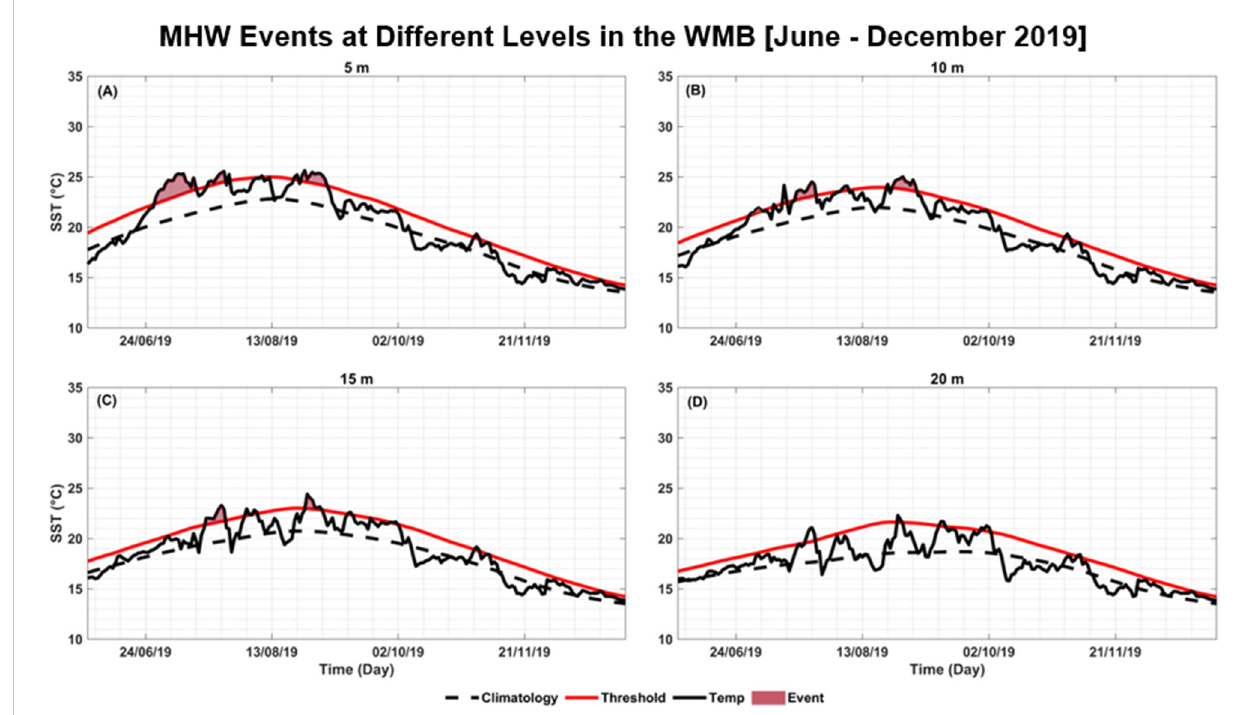
FIGURE 8 The penetration of MHW events into the water column in the WMB at different depths (A) 5m, (B) 10m, (C) 15m, and (D) 20m. The red shaded area refers to the MHW event. The black solid line represents the water temperature, the black dotted line represents the climatology, and the red solid line represents the